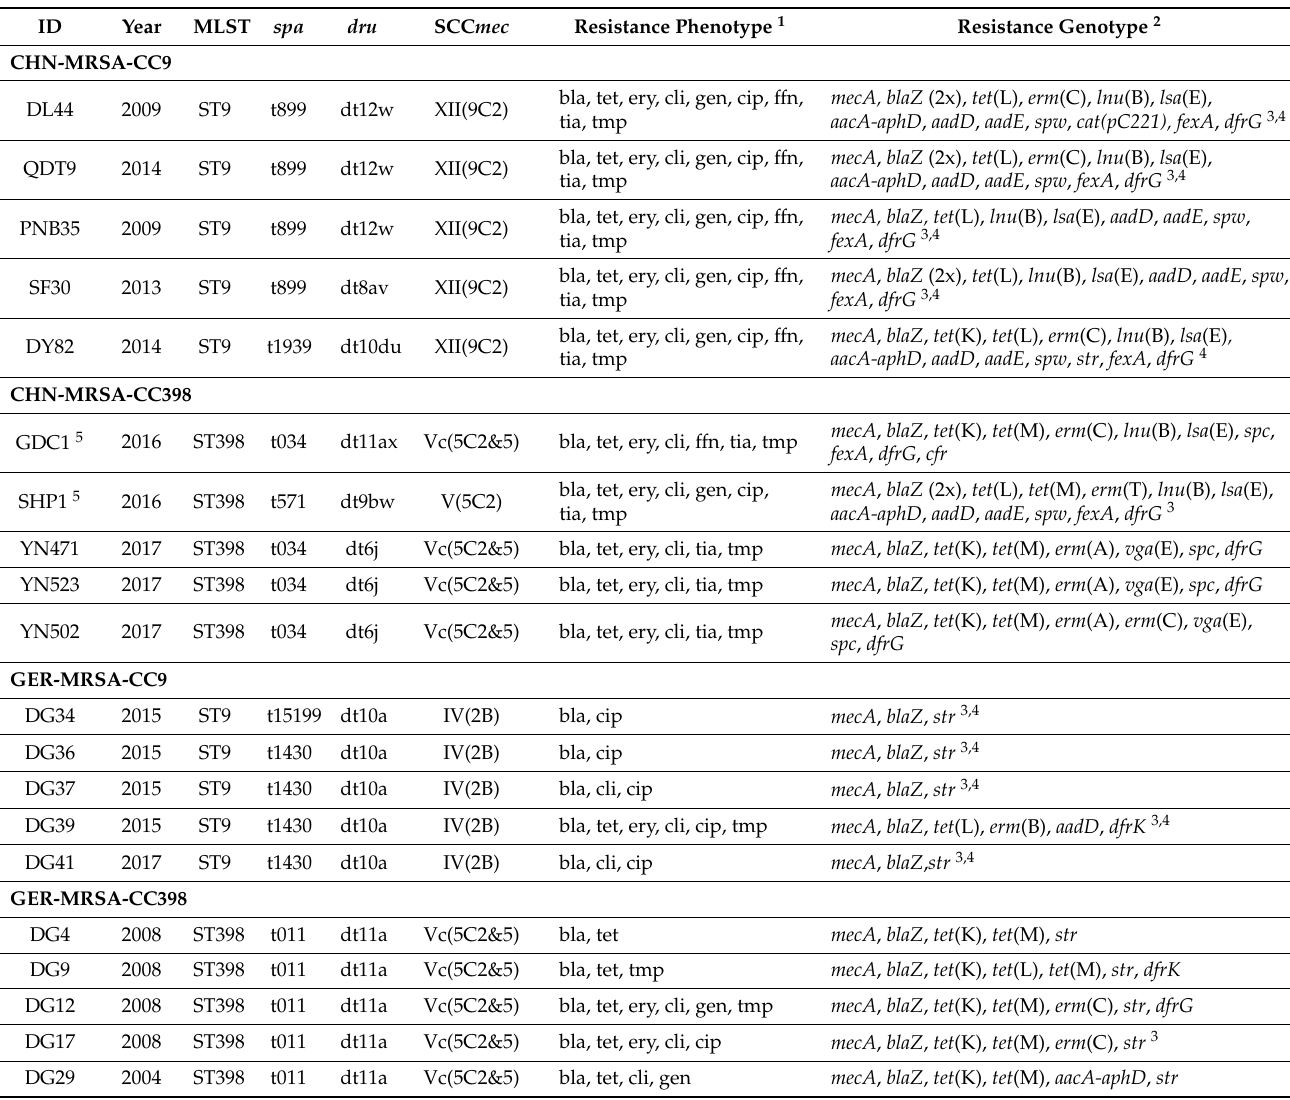
Table 1. Characteristics of the representative bacterial isolates of swine origin selected for Biolog PM